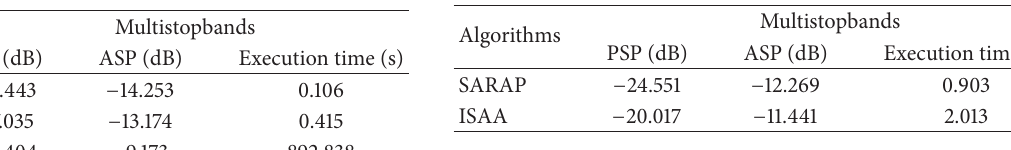
Table 4: Algorithms comparison for suppressing narrow interfer- ence in multistopbands.